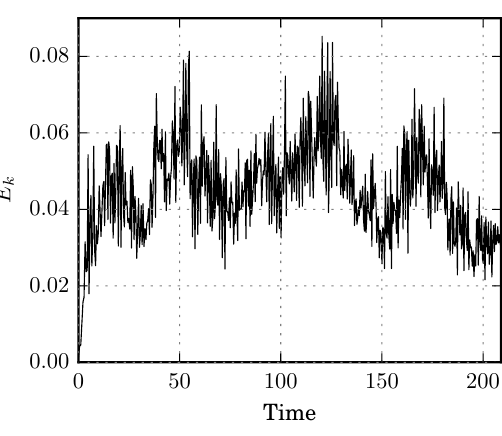
Figure 1. Time-series of average kinetic energy showing a statistically steady